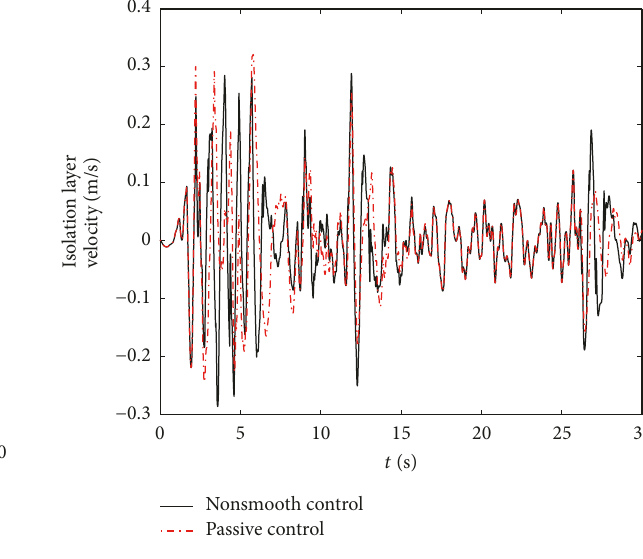
Figure 4: Velocity response of isolation layer.